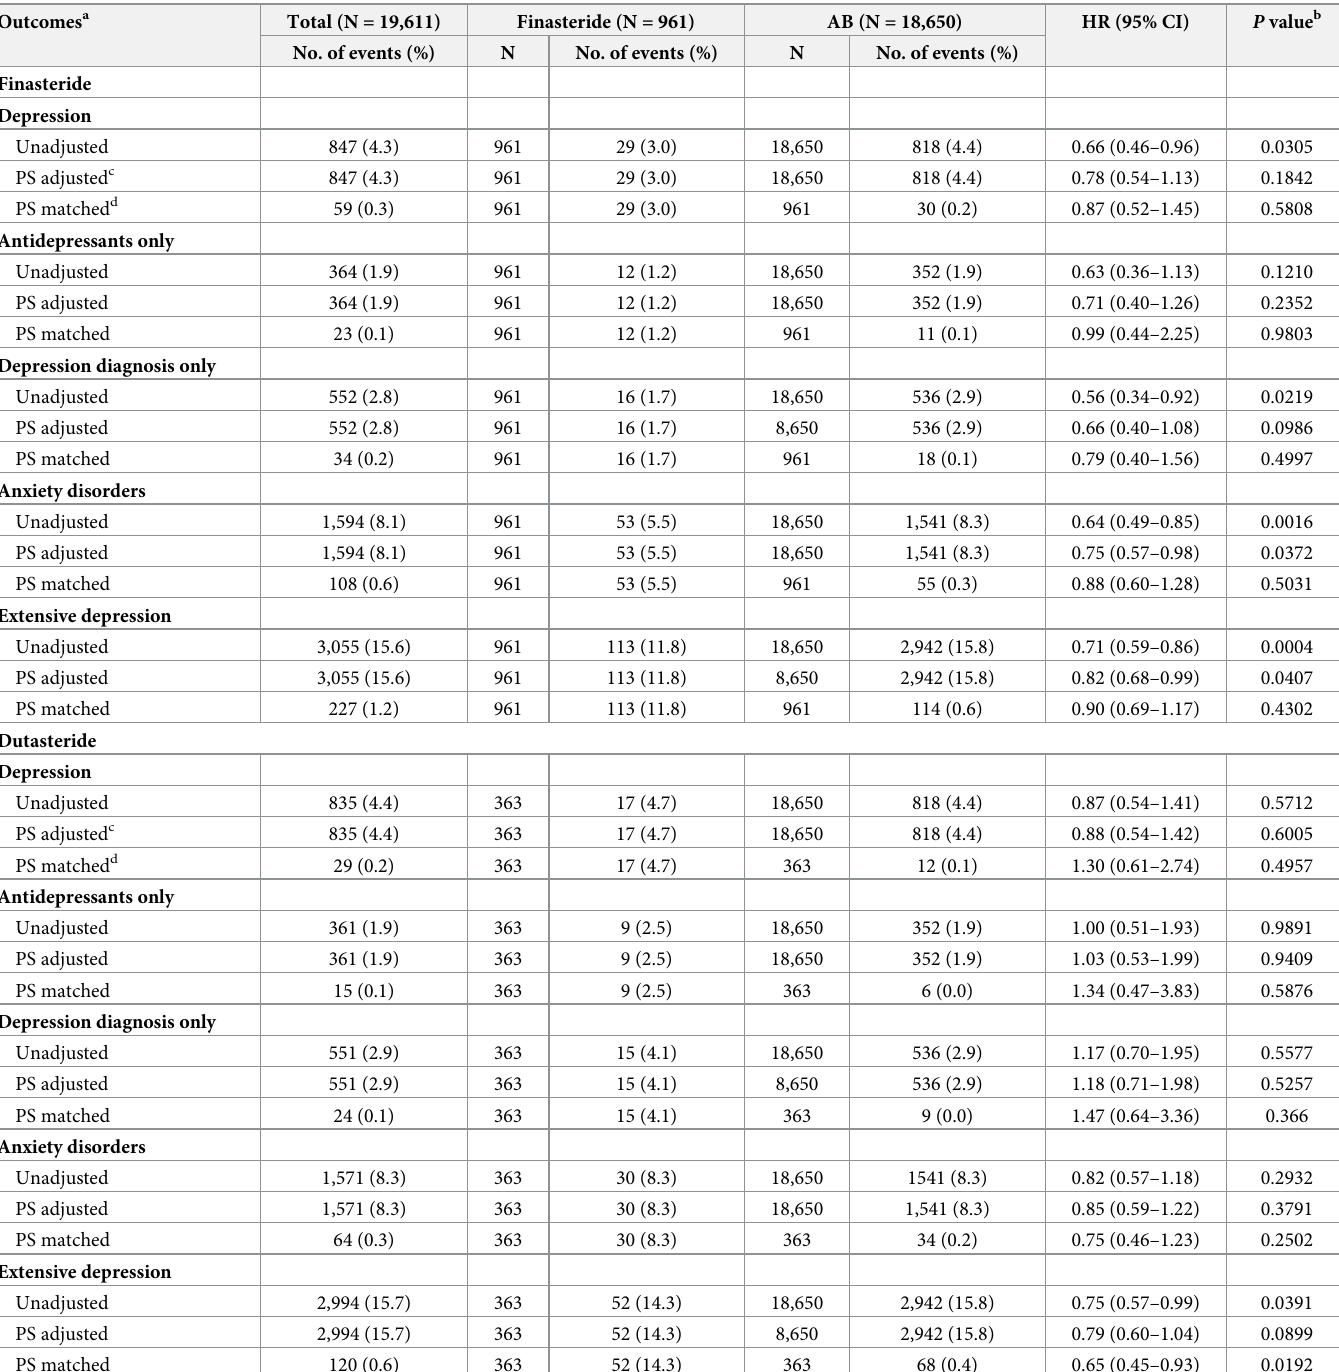
Table 3. Risk of depression anxiety disorders and extensive depression outcomes stratified by initial 5ARI